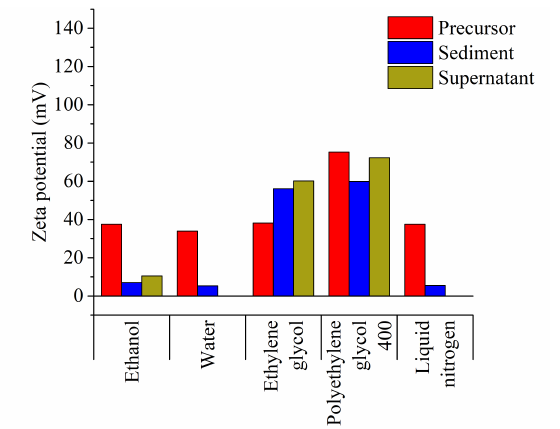
Figure 2. Zeta potential values for the precursor (the non-irradiated colloid of the carbonyl iron microparticles), the sediment, and the supernatant extracted from the irradiated samples, all dispersed in the corresponding solvents (ethanol was used in case of the samples prepared in liquid